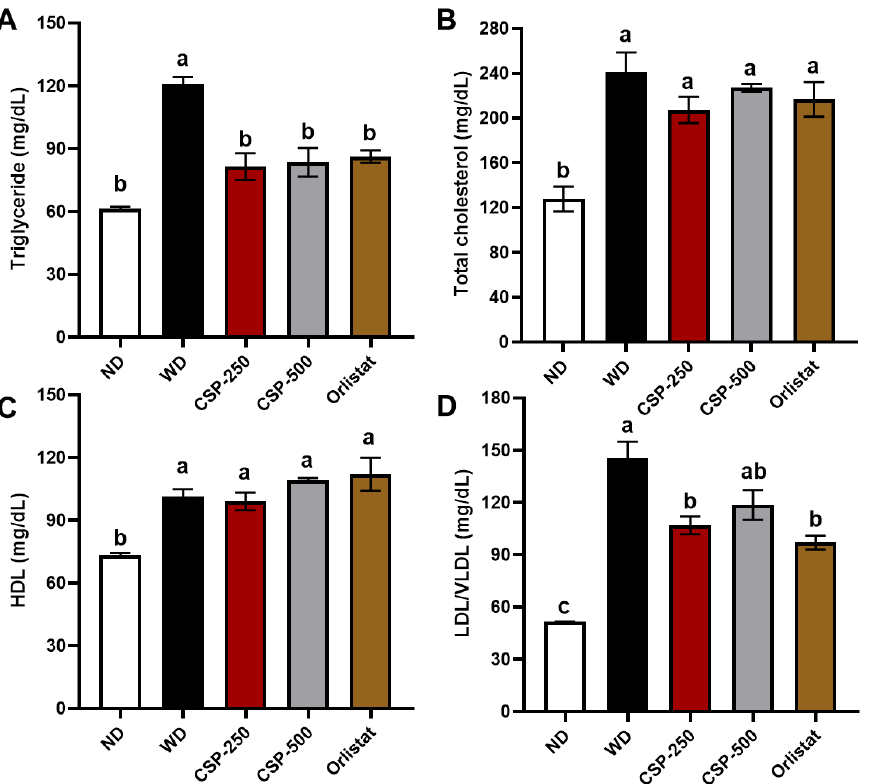
Figure 2. Effect of canary seed peptides (CSP) administration on serum biochemistry after eight weeks of diet-induced intervention in C57BL/6J mice. Fasting serum levels of triglycerides ( A ), total cholesterol ( B ), high density lipoprotein ( C ), and low/very-low density lipoprotein ( D ). ND, normal diet; WD, Western diet; CSP-250, mice supplemented with 250 mg/kg of body weight of CSP; CSP-500, mice supplemented with 500 mg/kg of body weight of CSP; Orlistat, mice supplemented with 40 mg/kg of body weight of orlistat. Bars and lines represent mean values ± SEM ( n = 8 per treat- ment). Different letters (a – c) indicate statistical differences ( p < 0.05) between treatments.